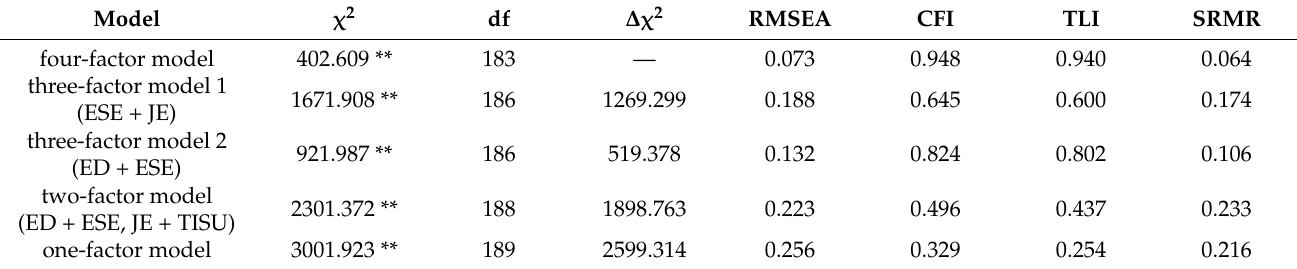
Table 5. Results of confirmatory factor